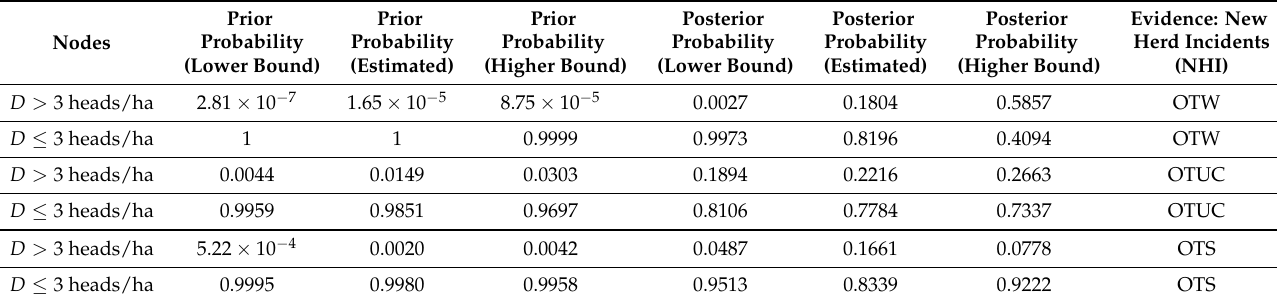
Table 6. Prior and posterior probabilities for node D in high-risk areas of England cattle farms.